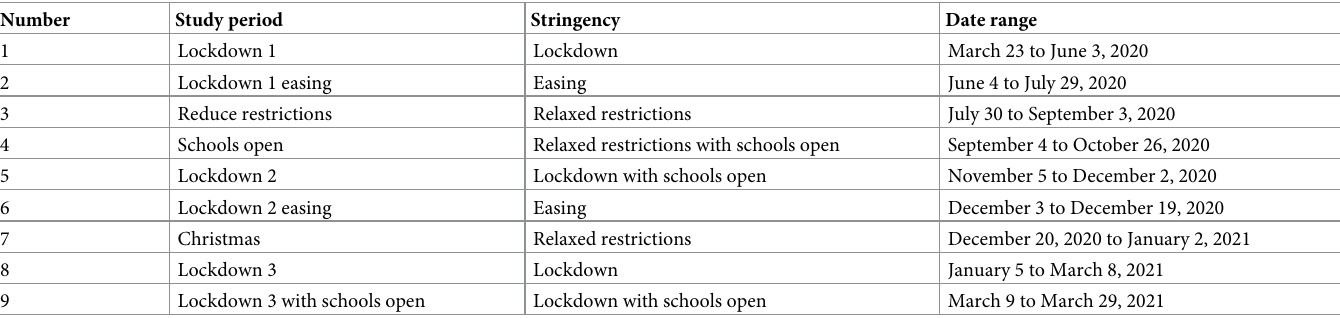
Table 1. Study periods by intervention type and date range in